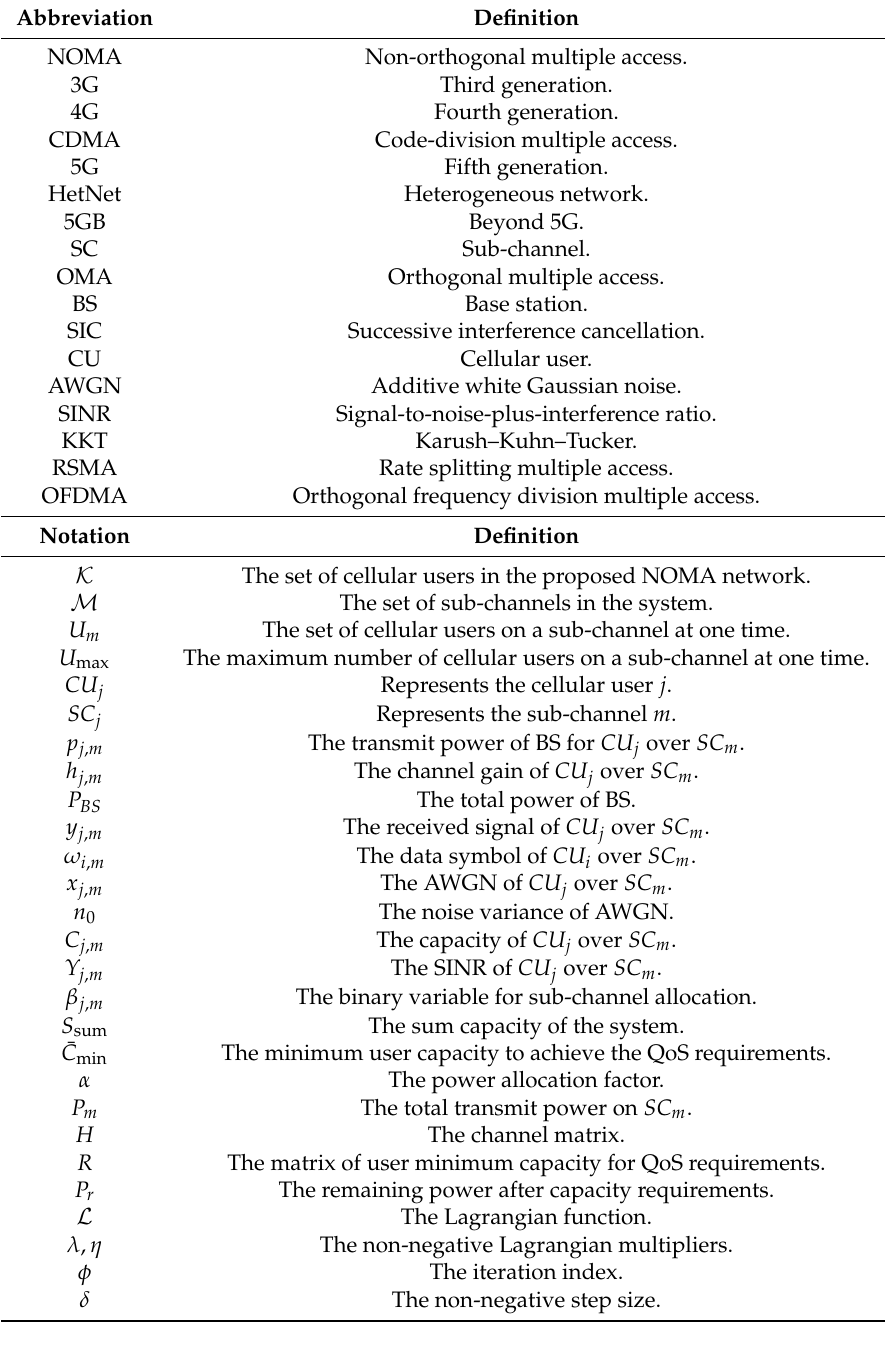
Table 1. Definition of different abbreviations and notations used in this